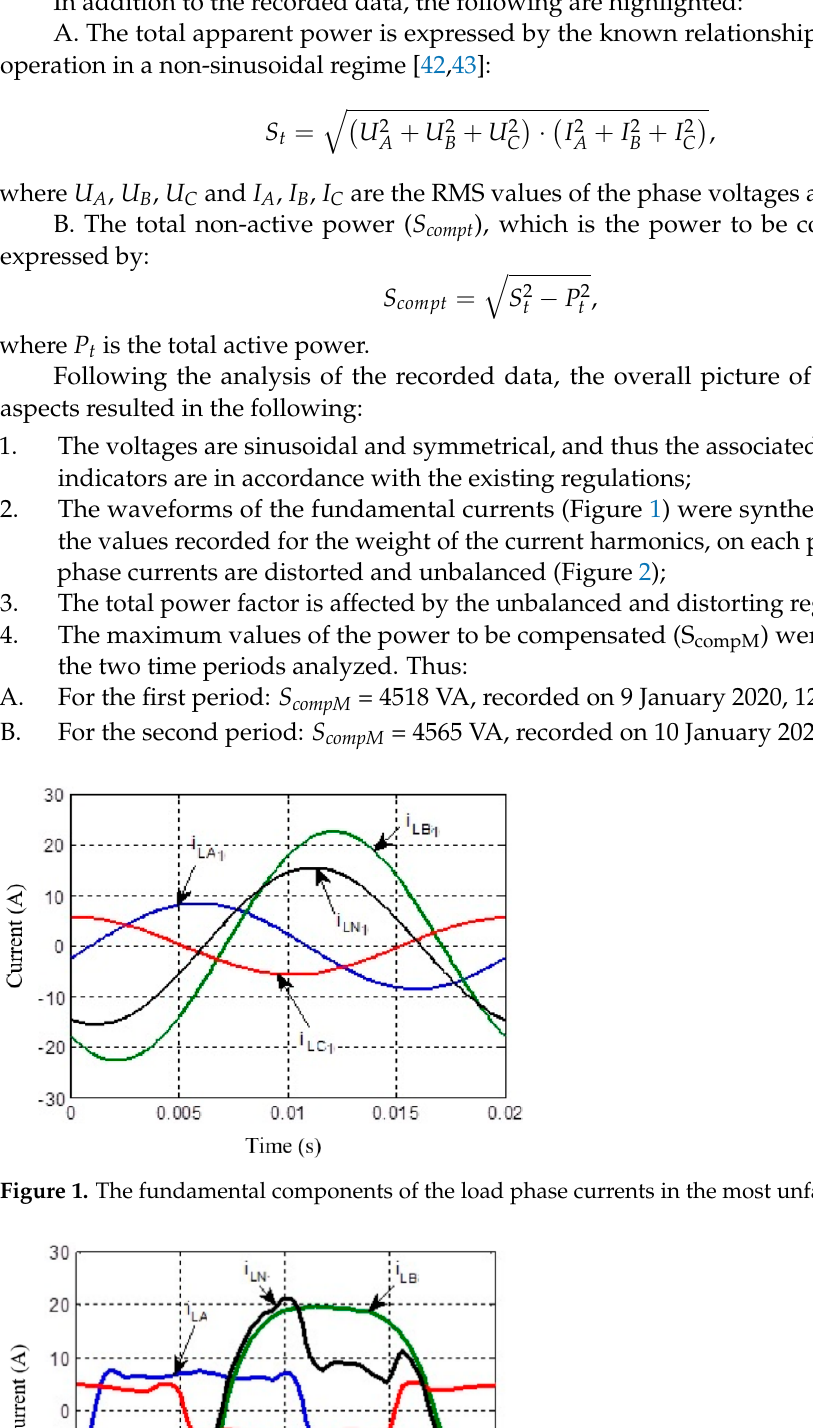
( a ) ( b ) Figure 3. The power factor for each phase: ( a ) during the first period (9 January 2020); ( b ) during the second period (10 January 2020).